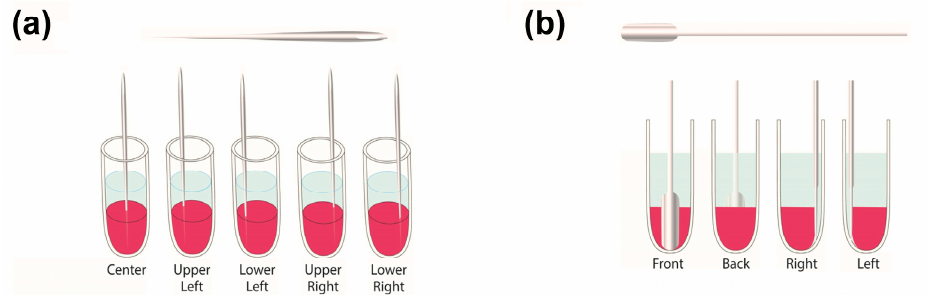
Figure 1. Mechanical stimulation schemes showing the approximate locations of the ( a ) perforations by the 5 needle jabs and ( b ) compressive spatula insertions. The perforated samples were jabbed multiple times during each treatment, while those subjected to compression were compressed once per treatment, either on the front, back, left, or right side of the sample.